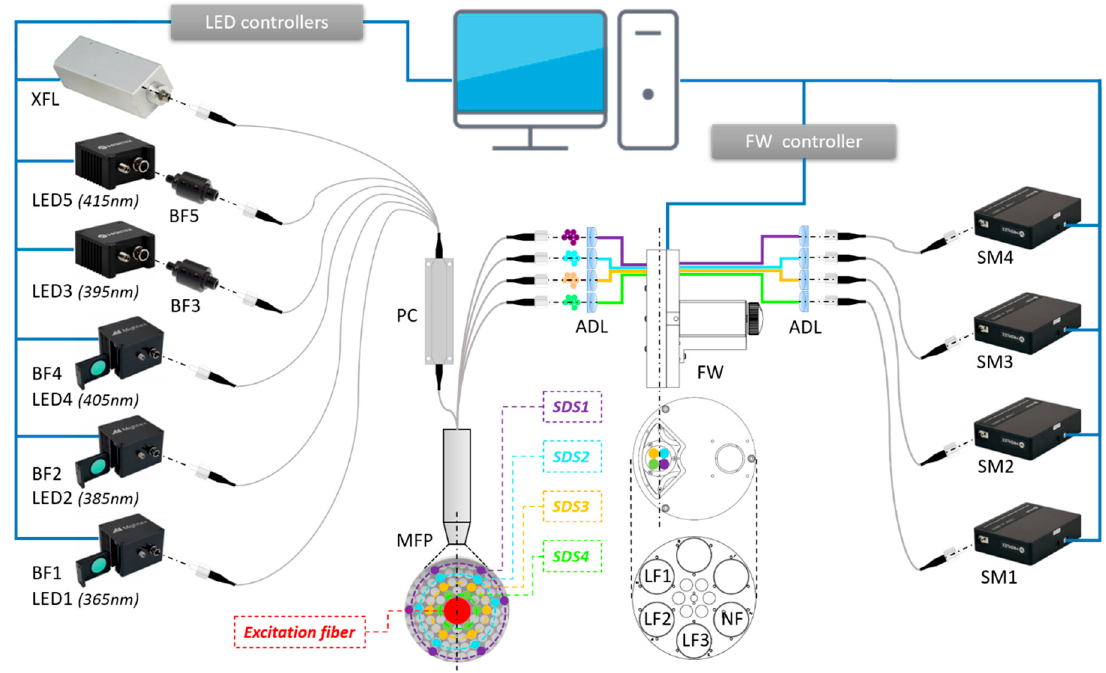
Figure 1. General scheme of the SpectroLive device optical principle. XFL: xenon flash lamp for broadband diffuse reflectance (DR) measurements; LEDi (i ∈ {1,2,3,4,5}): light-emitting diodes for narrow band together with BFi excitation bandpass filters for narrow-band autofluorescence (AF) excitations; MFP: multiple fiber probe (see details in Figure 2); PC: power combiner; ADL: achromatic doublet lens; FW: filter wheel; SDSj (j ∈ {1,2,3,4}): source-to-detector separations; LFk (k ∈ {1,2,3}): emission long ‐ pass filters; NF: neutral density filter; SMj: spectrometers.